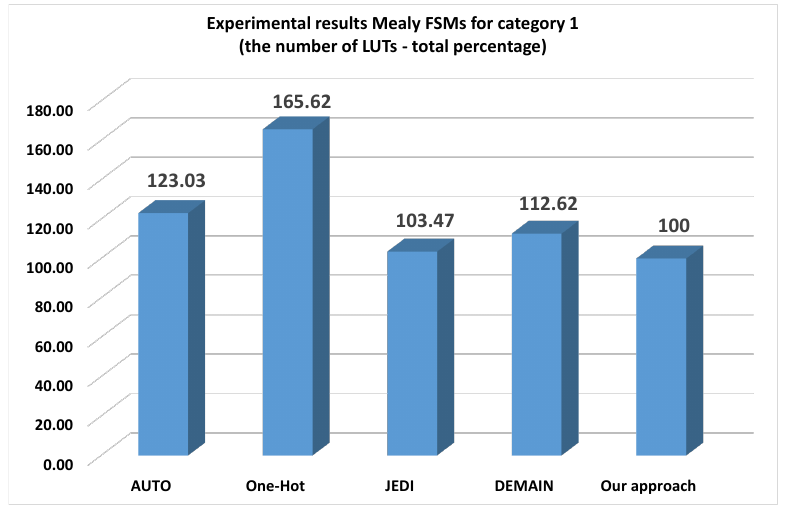
Figure 10. Experimental results for category 1 (the number of LUTs—total percentage).